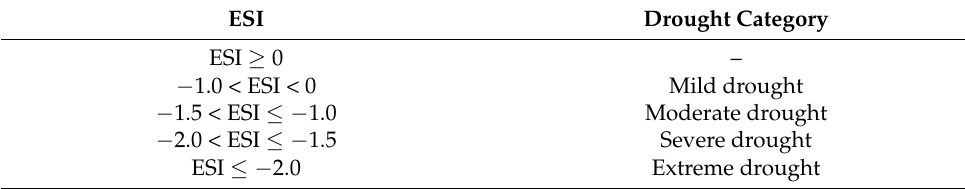
Table 1. Drought category according to evaporative stress index (ESI). ESI Drought